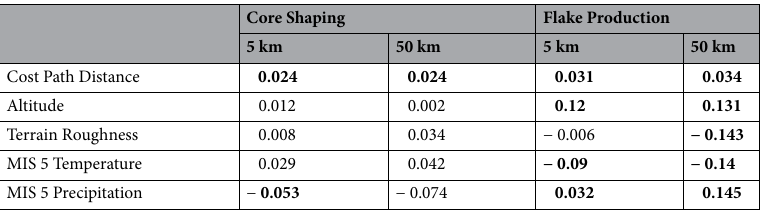
Table 2. Results of multiple-matrix regressions between patterns of Levallois core shaping and flake production with alternate examination of geographic parameters at 5 km and 50 km scales, reporting correlation coefficients in bold where significant independent relationships are identified (see